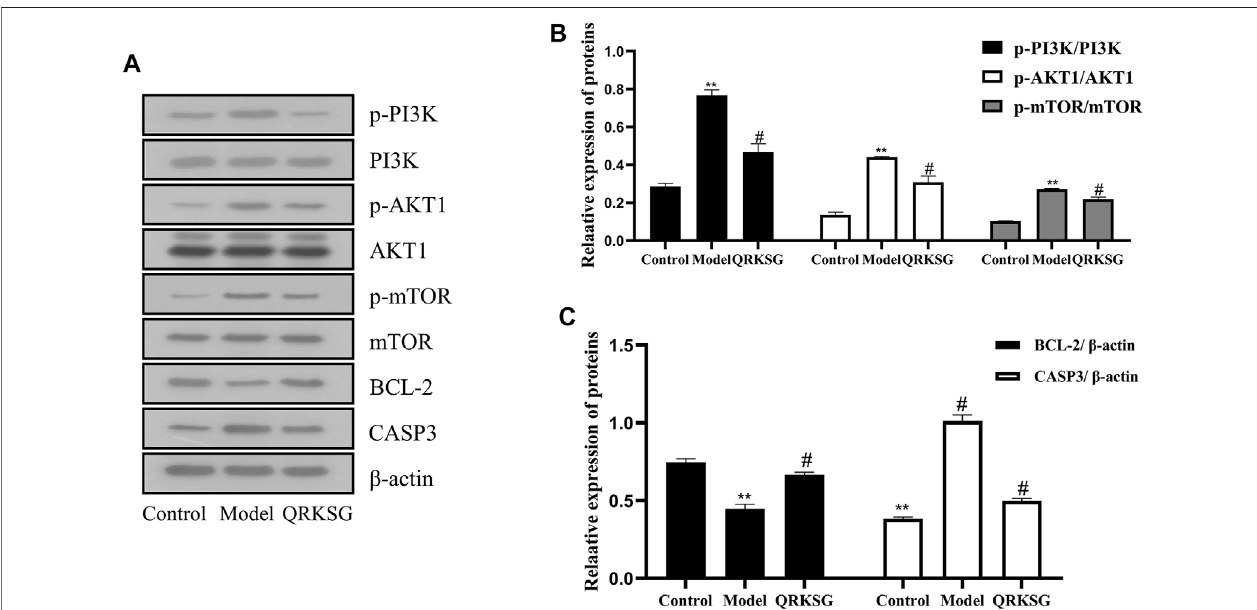
FIGURE 11 | Western blot analysis of PI3K, AKT1, mTOR, BCL-2, and CASP3. (A) Representative images of PI3K, AKT1, mTOR, BCL-2, and CASP3 (B) PI3K, AKT1, and mTOR protein expressions (C) BCL-2 and CASP3 protein expressions. The data are presented as mean ± SD, ** p < 0.05 shows comparison against the control group, while # p < 0.05 shows comparison against the model